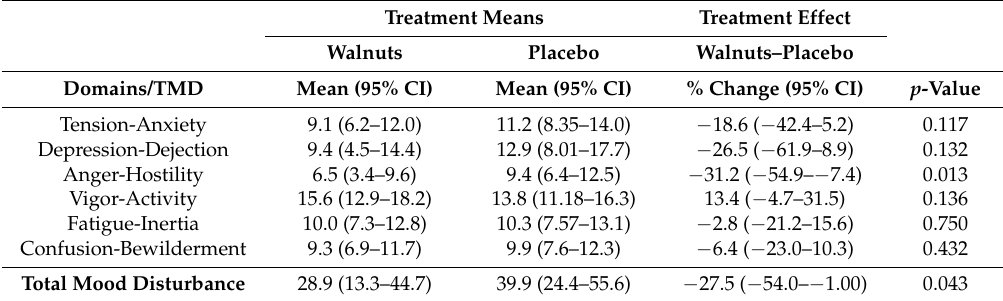
Table 5. Mean scores and changes in POMS for males on walnut and placebo diet ( n = 20).